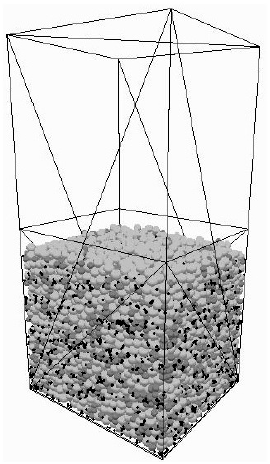
Figure 1. Initial configuration of mixture with size ratio of 3.75 and number fraction f = 424. Table 2. Values of D k along with N for a given value of g in mixtures with particle size distribution (PSD) uniform by number of spheres.